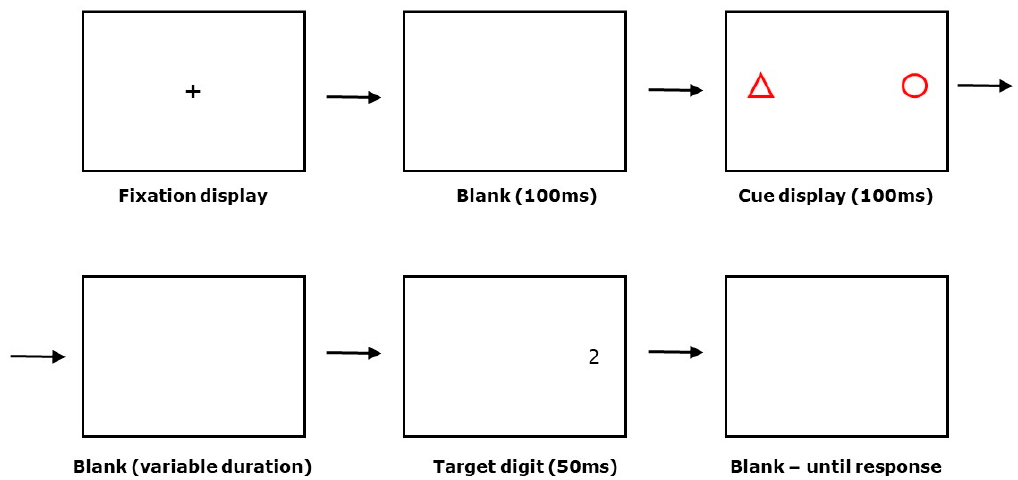
Figure 1. Structure of an individual trial in the Vision for Action Test (see text for further details).